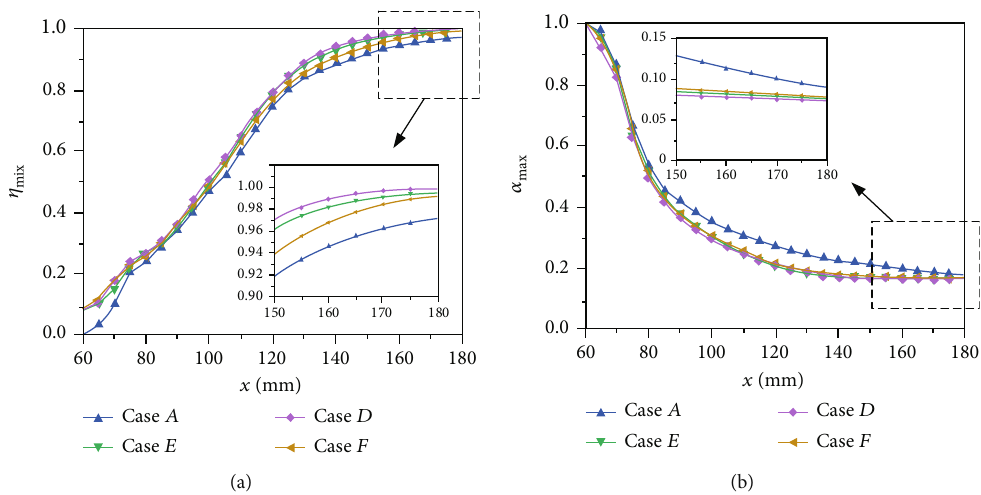
Figure 12: Mixing e ffi ciency of ethylene (a) and the corresponding maximum concentration decay curve (b) in case A without actuation and cases D - F with spanwise actuation upstream of the ori fi ce.